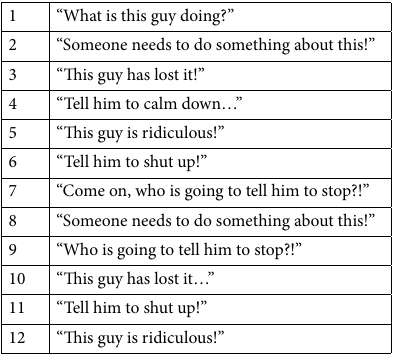
Table 1. Sequence of utterances that virtual bystanders might said out loud during the confrontation. Two different actors were used, so that where the expression is the same (e.g., 5 and 12) they sounded